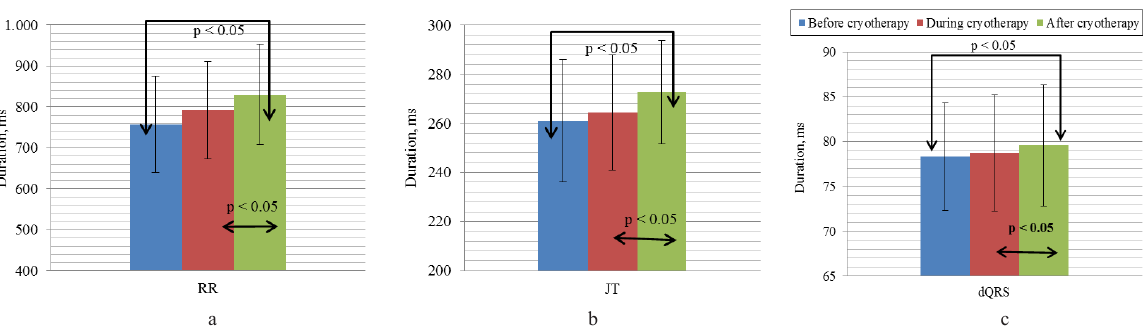
Changes in the amplitudes of ECG parameters during whole-body